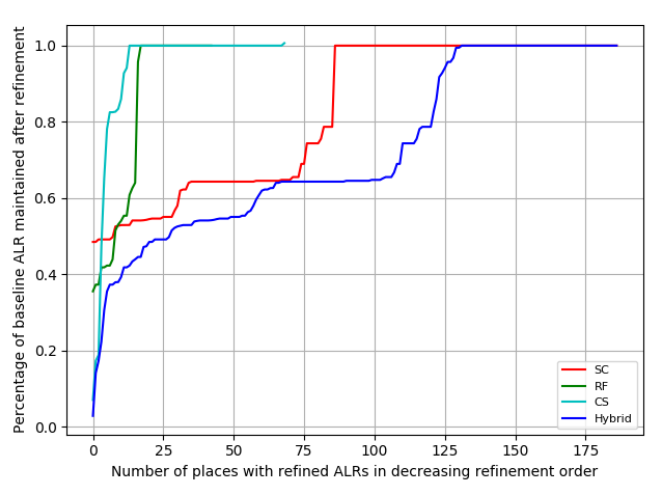
Figure 14. Refined approximate location region (ALR) sizes as percentages of the original (baseline) ALR size using the SC, RF, CS, and Hybrid